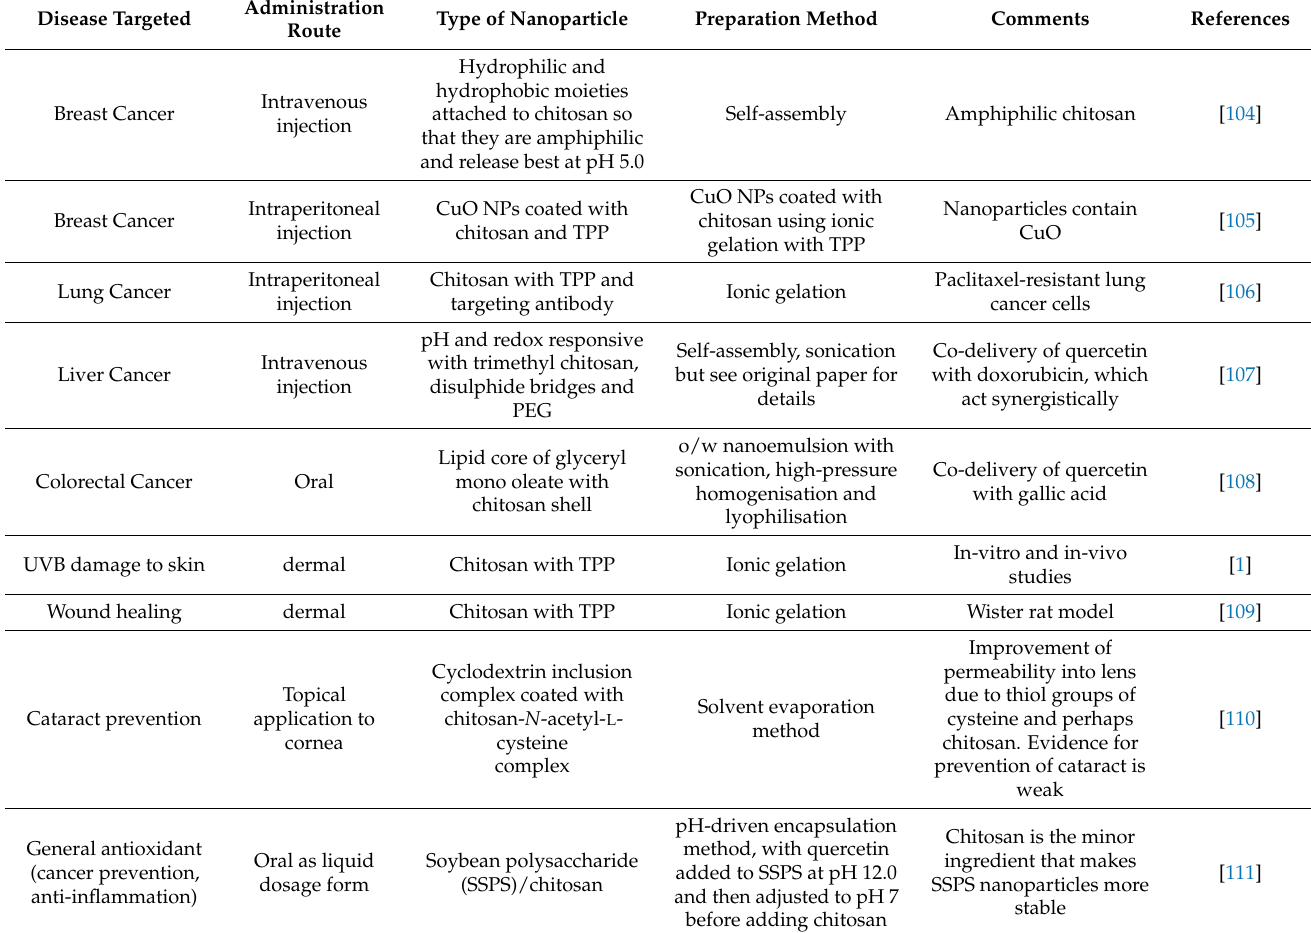
Table 2. Potential chitosan nanoparticle drug delivery systems for quercetin. Data from [1,104–111]. Administration Disease Targeted